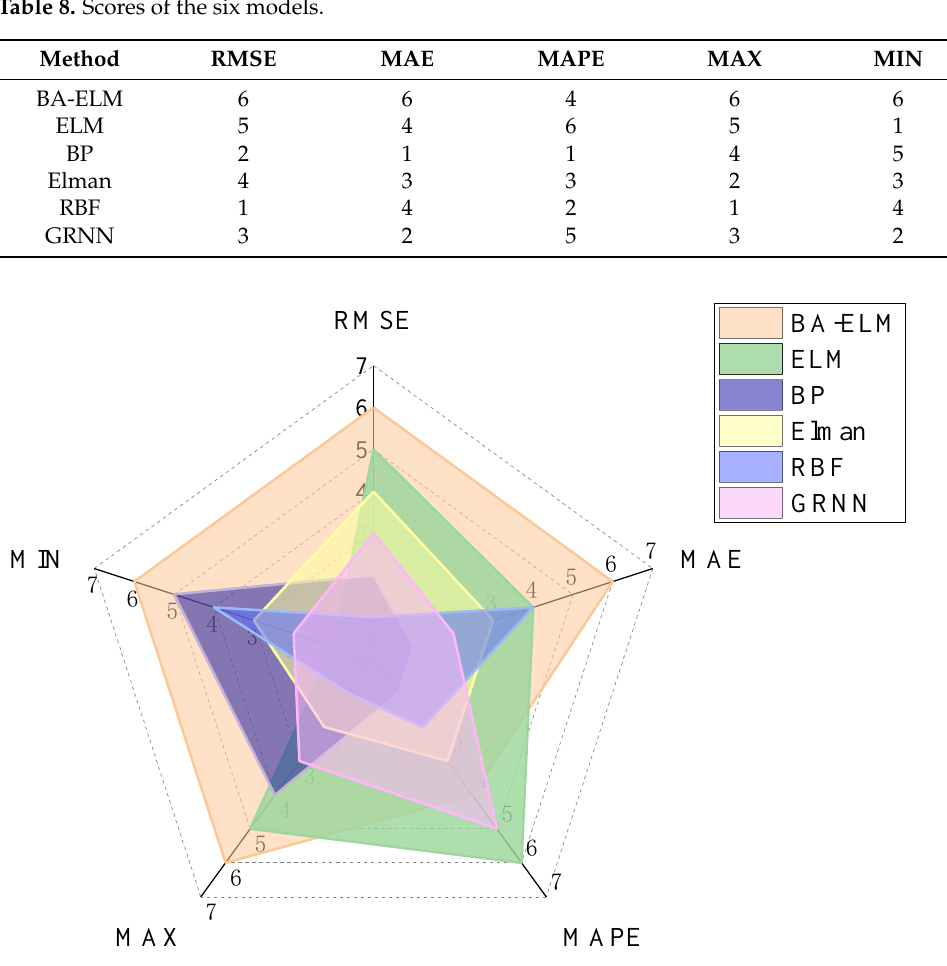
Figure 20. Radar chart of the statistical error of each